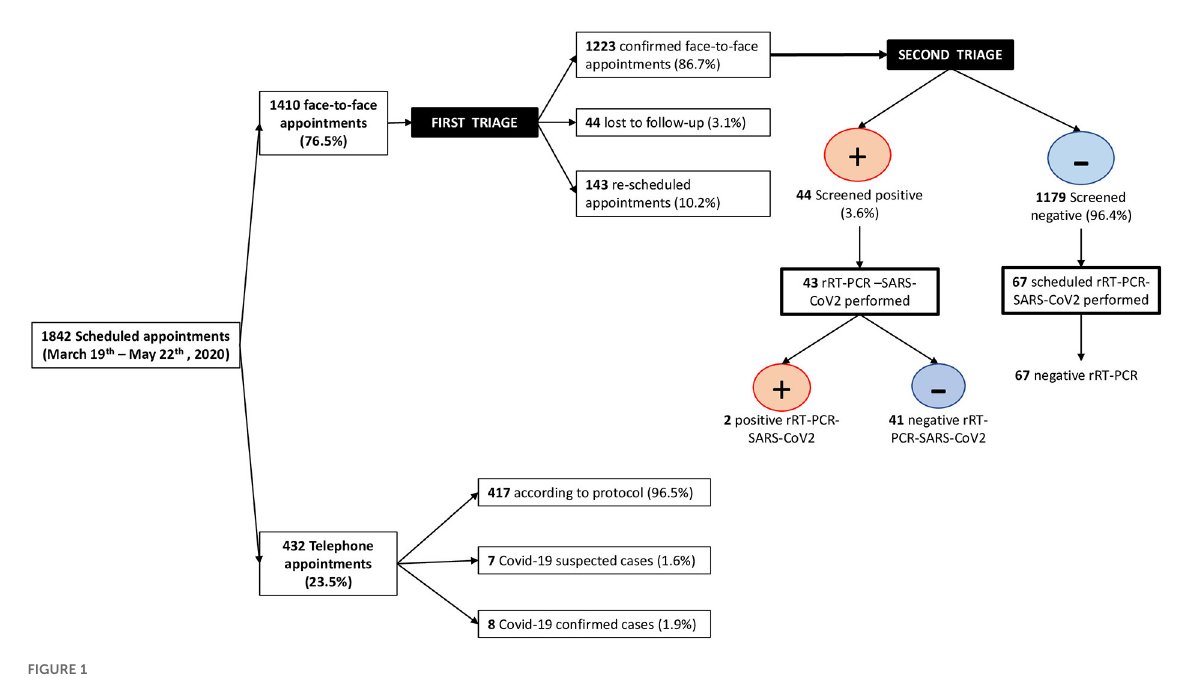
FIGURE1 Patients diagram